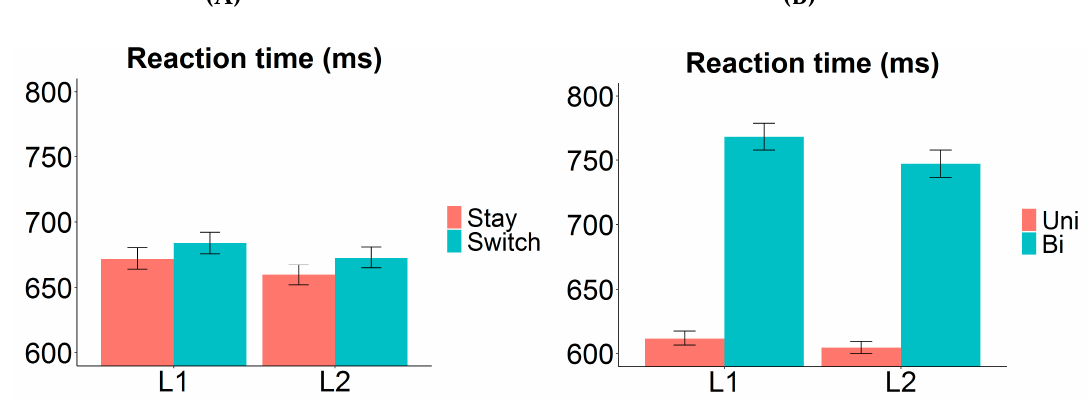
Figure 6. Switch cost and valence cost in Experiment 2. ( A ) Reaction time as a function of “response language” (L1 vs. L2) and “transition type” (stay vs. switch trials). The switch cost was symmetrical between the two languages. ( B ) Reaction time as a function of “response language” (L1 vs. L2) and “valence” (univalent vs. bivalent items). The valence cost was asymmetrical (larger in L1). Error bars indicate one standard error above and below the means. Uni = univalent items; Bi = bivalent items. The disruption of pre-SMA activity using TMS had an overall impact on participants’